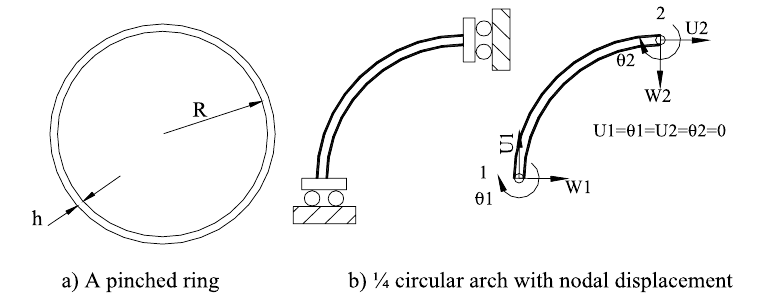
Fig. 4. A circular pinched ring and model for 1/4